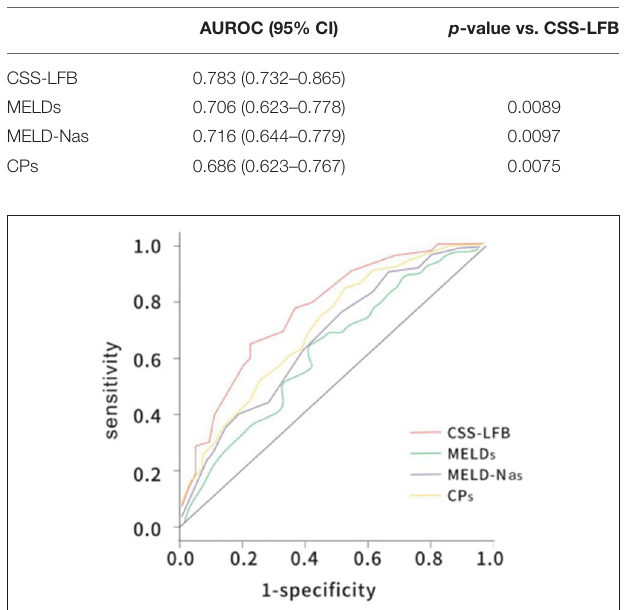
TABLE 5 | Comparison of the area under the ROC curve of predicting short-term (30 days) prognosis of patients with hepatitis B liver failure among Chinese scoring system, MELD score, MELD-Na scoring, and CTP scoring.